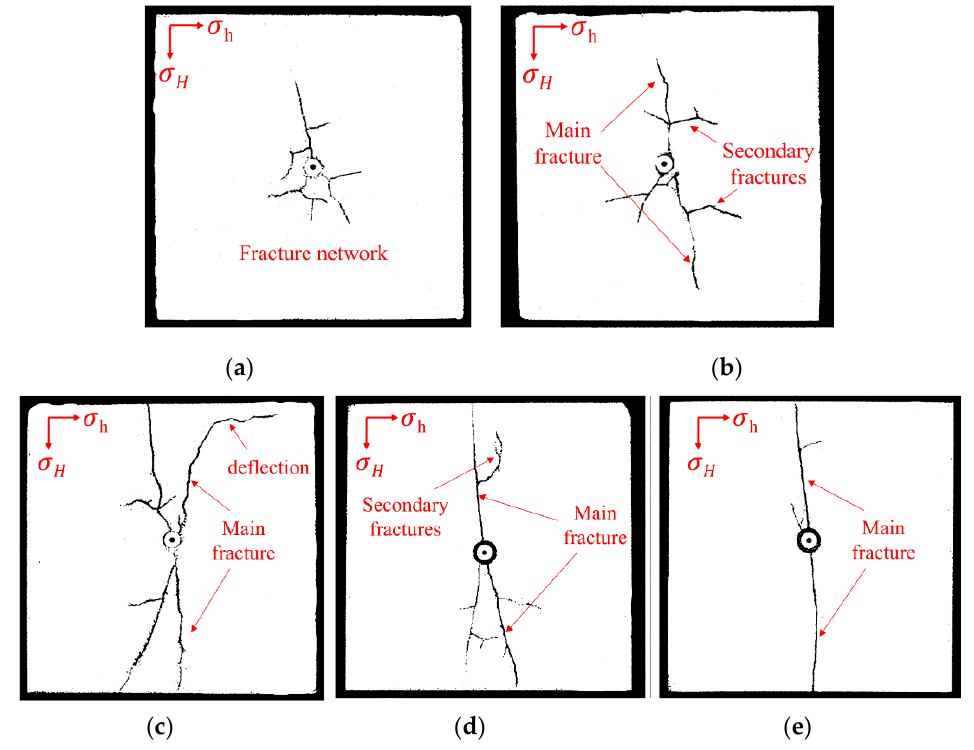
Figure 5. CT scanning images with supercritical carbon dioxide under various stress states after grayscale manipulation. ( a ) σ H - σ h = 0; ( b ) σ H - σ h = 1 MPa; ( c ) σ H - σ h = 2 MPa; ( d ) σ H - σ h = 3 MPa; ( e ) σ H - σ h = 4 MPa. With the decrease of stress difference, a fracture network with more secondary fractures is more easily induced.